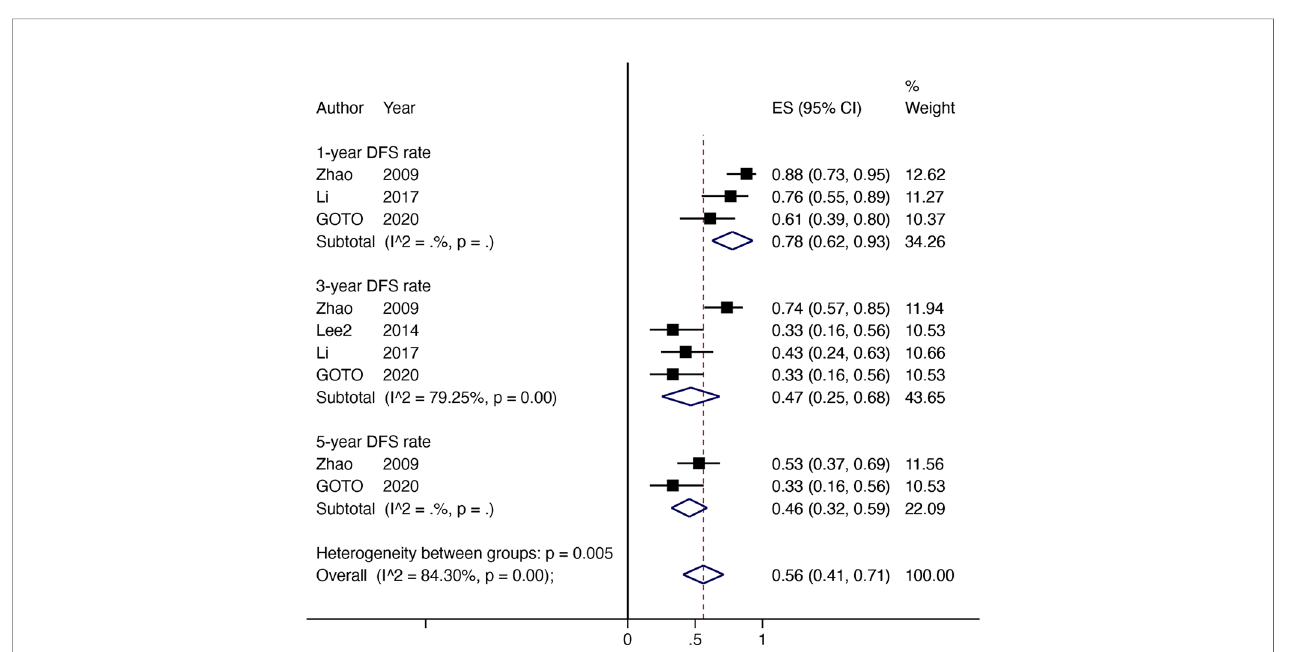
FIGURE 2 | The overall downstaging success rate of hepatic resection of HCC (A) , pooled downstaging rate strati fi ed by TACE and CT (B) , pooled downstaging rate strati fi ed by mono/multitherapy (C) ; pooled downstaging rate strati fi ed by cirrhosis included/excluded (D) . TACE, transarterial chemoembolization; CT, chemotherapy.